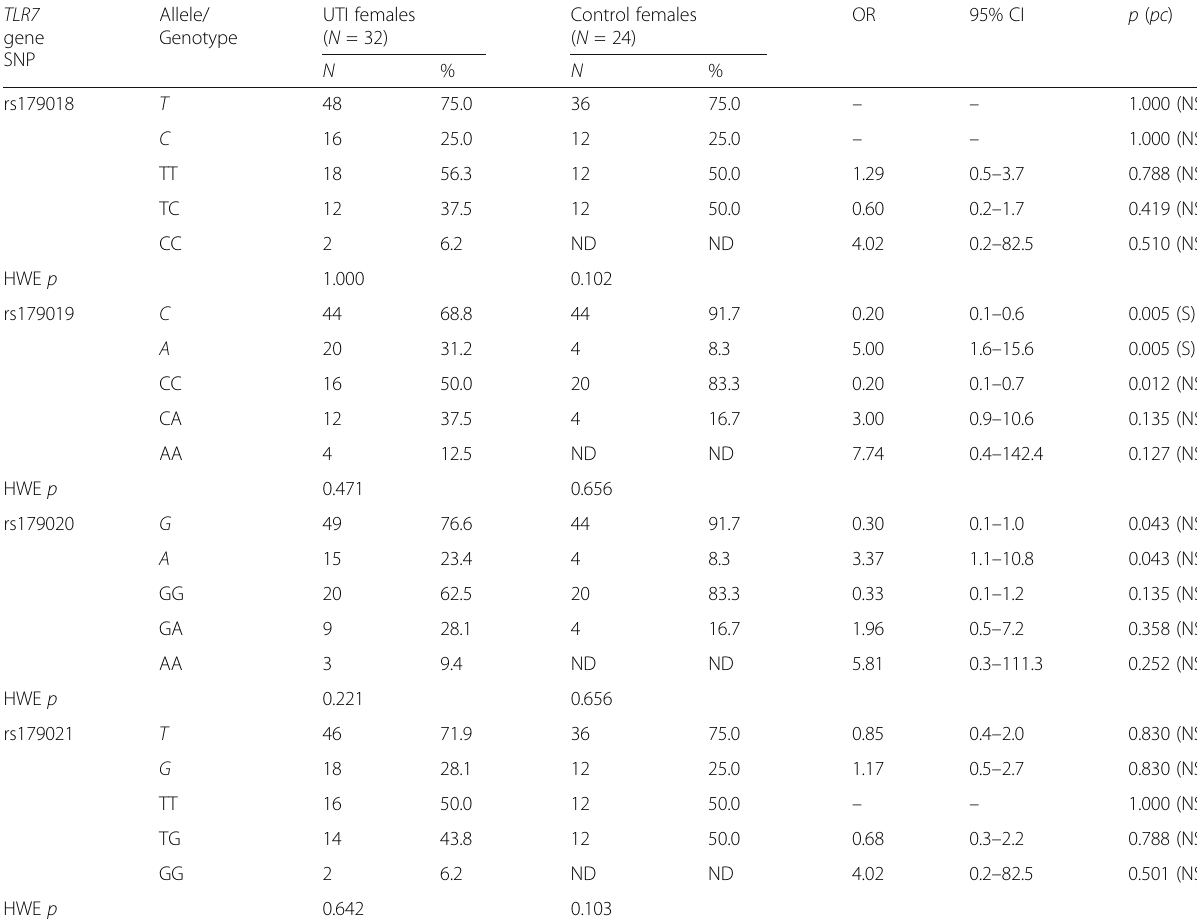
Table 4 Single-nucleotide polymorphisms of TLR7 gene in females of chronic urinary tract patients and control TLR7 gene